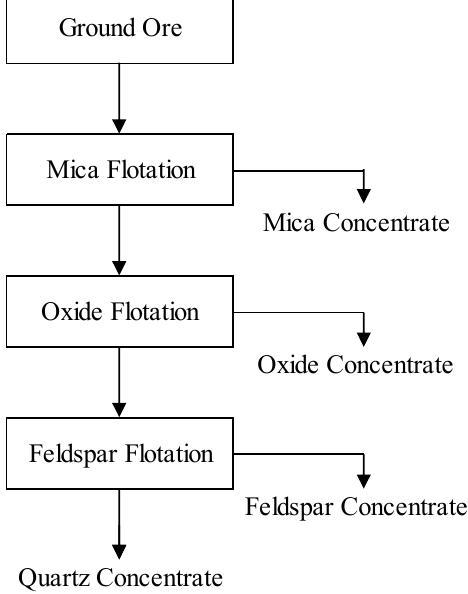
Figure 4. The bench flotation flowsheet for the determination of the optimum particle size. Table 1. Conditions for different flotation tests.